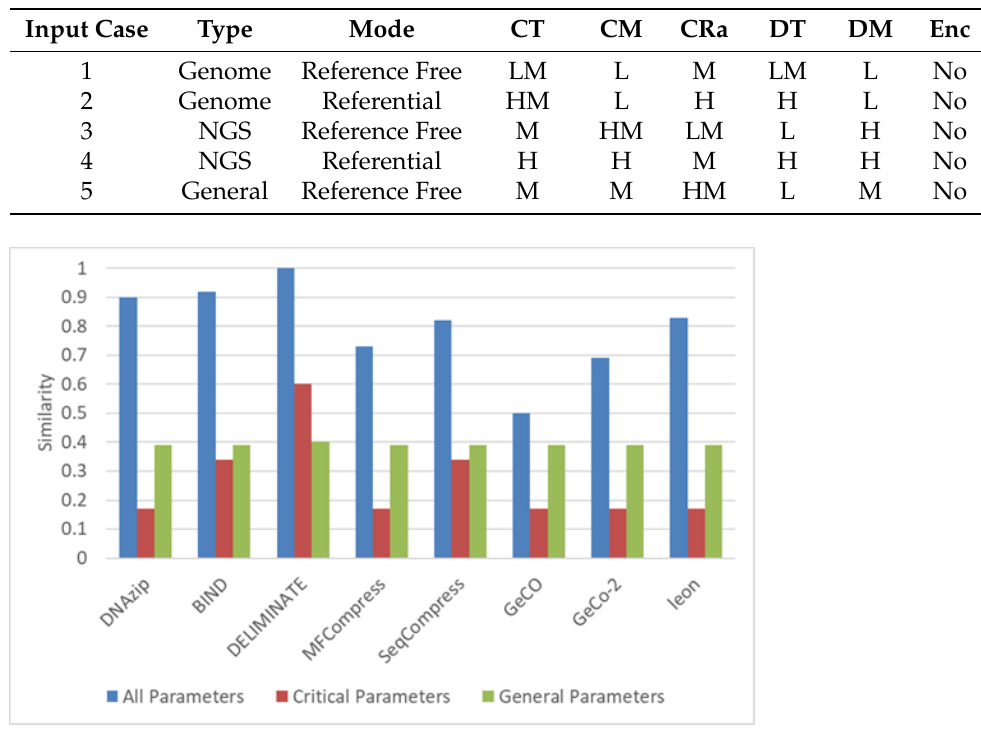
Figure 4. Similarity and weighting results of genome non-referential